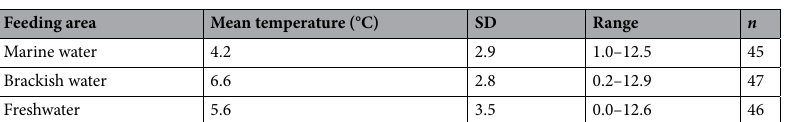
Table 1. Mean temperatures experienced by the brown trout during from 1 Oct 2018–28 Feb2019. n: number of unique fish with temperature measurements in each feeding area. Freshwater: < 5‰; Brackish water: 5–30‰; marine waters: >